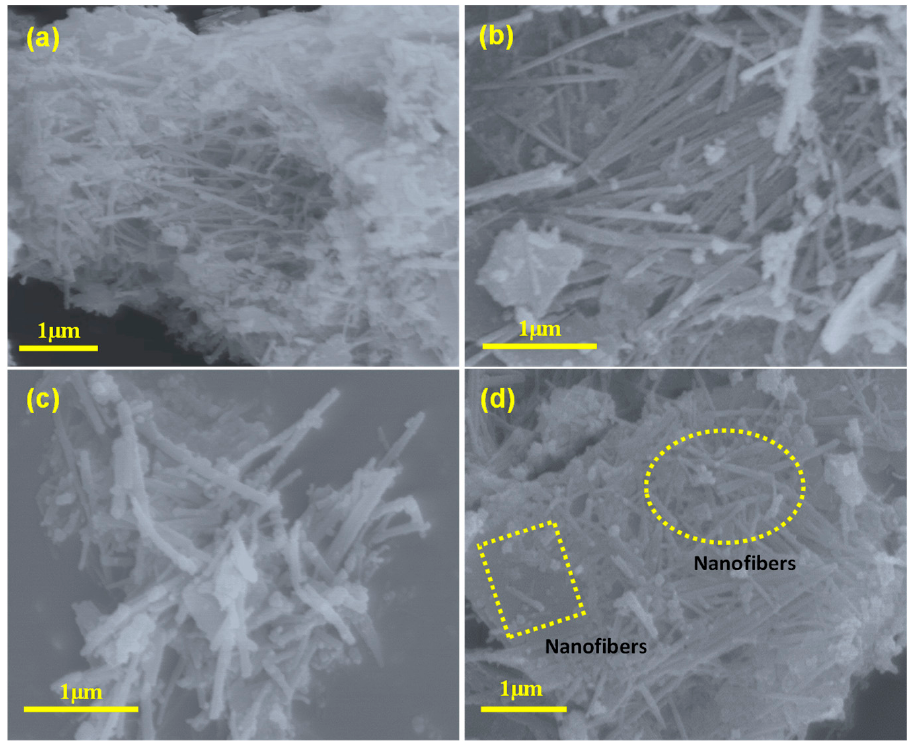
Figure 2. SEM images of CSLDH-1 at different locations.